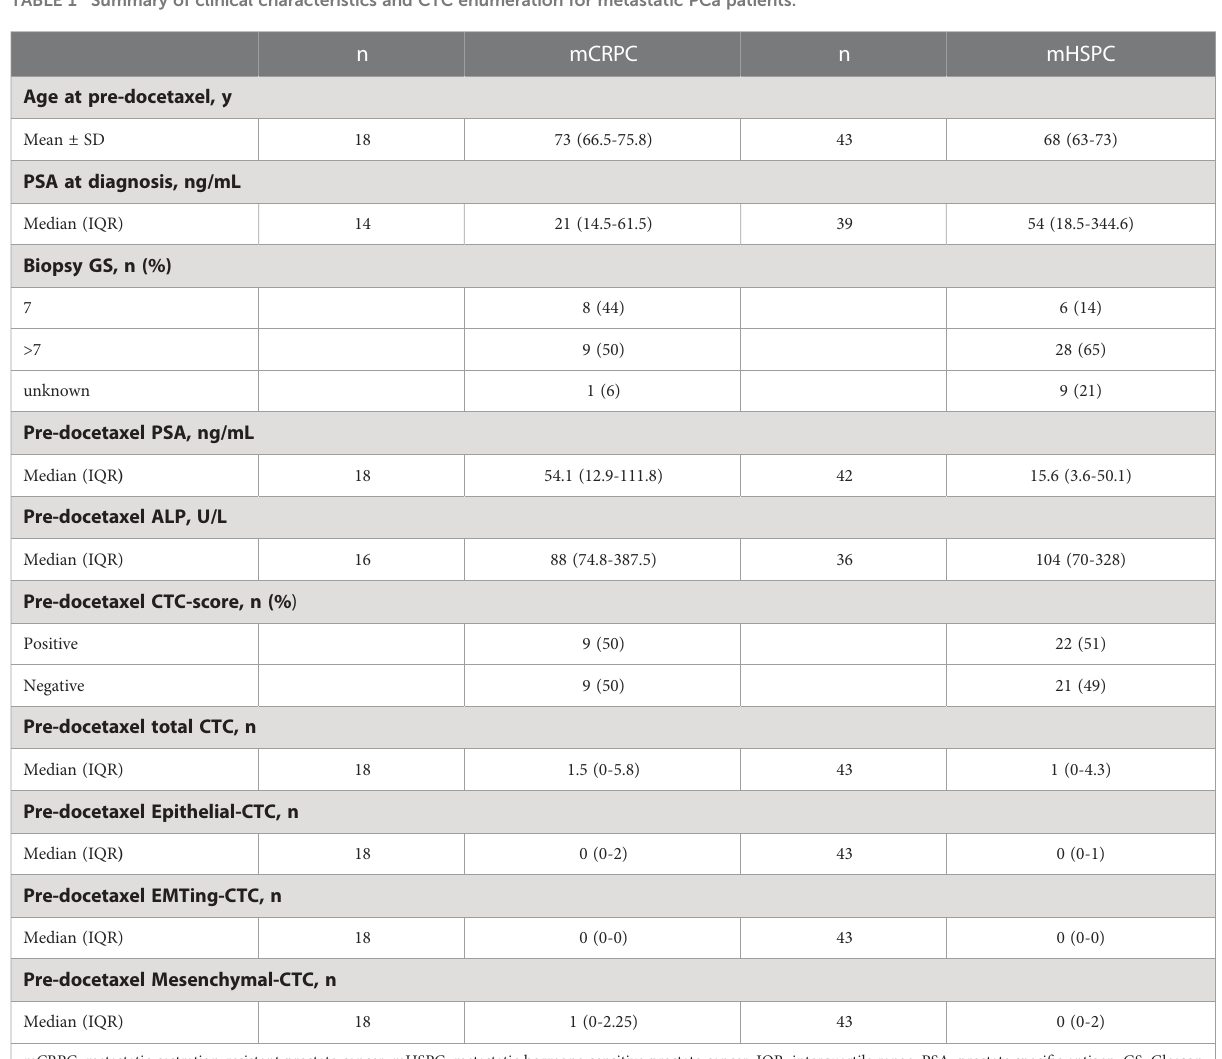
TABLE 1 Summary of clinical characteristics and CTC enumeration for metastatic PCa